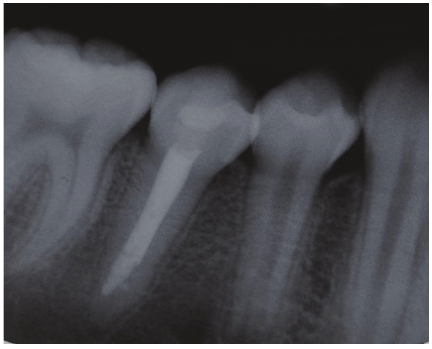
Figure 5: Periapical radiograph of tooth 45, 6-month postapexi fi cation showing complete root maturogenesis.